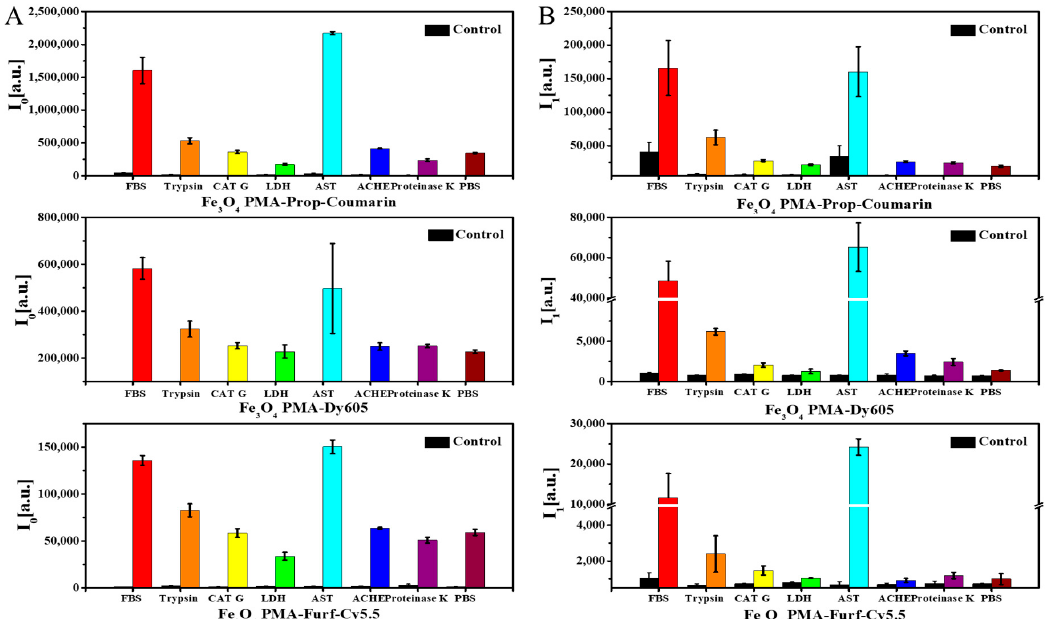
Figure 2. ( A ) Mean emission intensities I 0 of NP solutions as incubated with enzyme mixes. ( B ) Mean emission intensities I 1 of small fragments of NPs which, after enzymatic cleavage, were released from the NPs surface and which were collected by ultrafiltration. Data are shown for Fe 3 O 4 PMA-Prop- Coumarin NPs, Fe 3 O 4 PMA-Dy605 NPs, and Fe 3 O 4 PMA-Furf-Cy5.5 NPs “samples” (colored traces) and “controls” (black traces), which represent solutions of enzymes without added NPs.